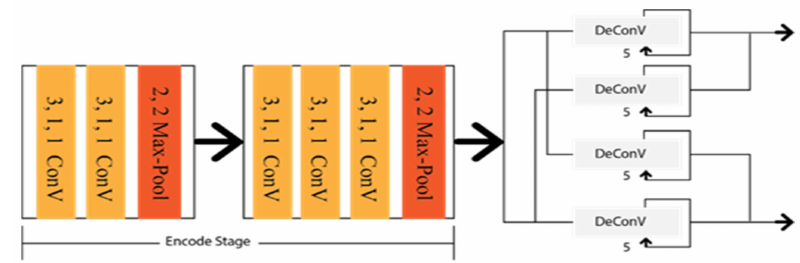
Figure 8. Schematic diagram of GLCNet.